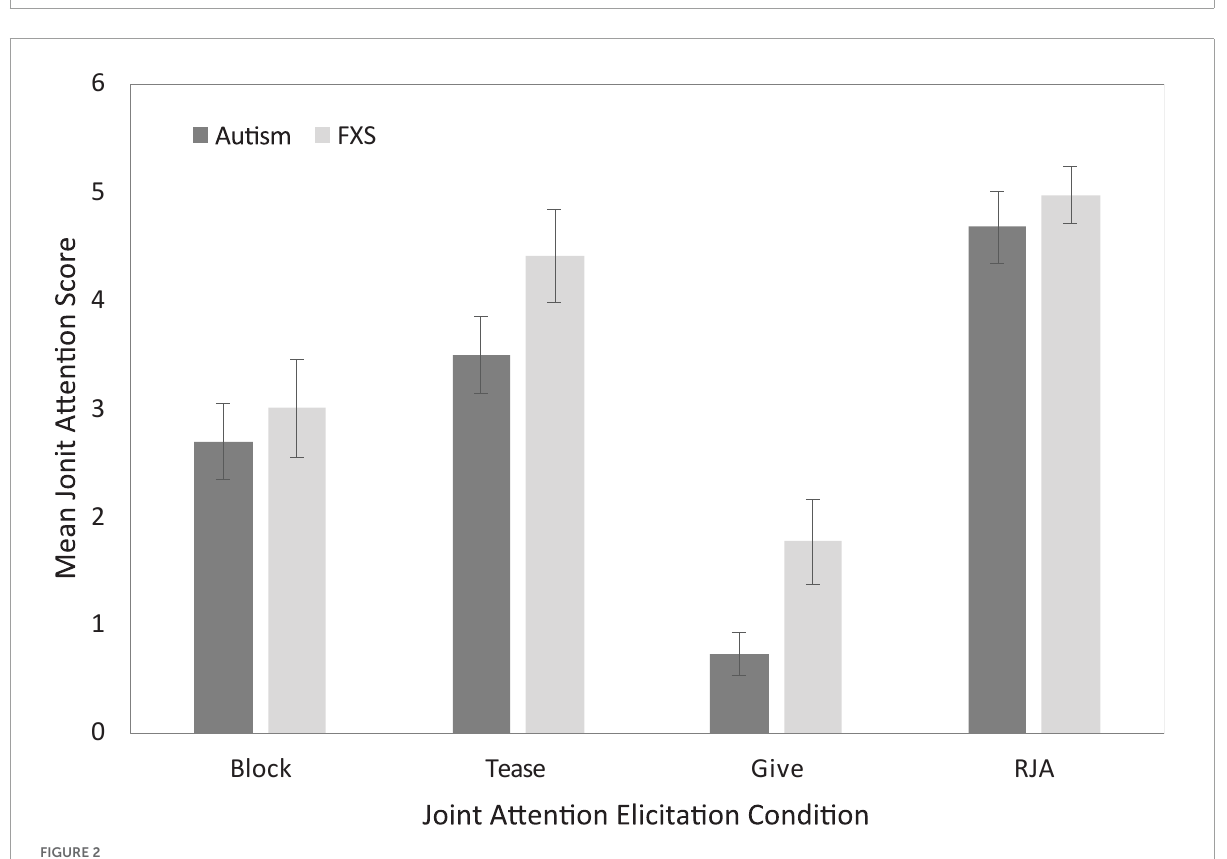
FIGURE2 Uncorrected between-group descriptive comparisons of joint attention performance as a function of elicitation condition.